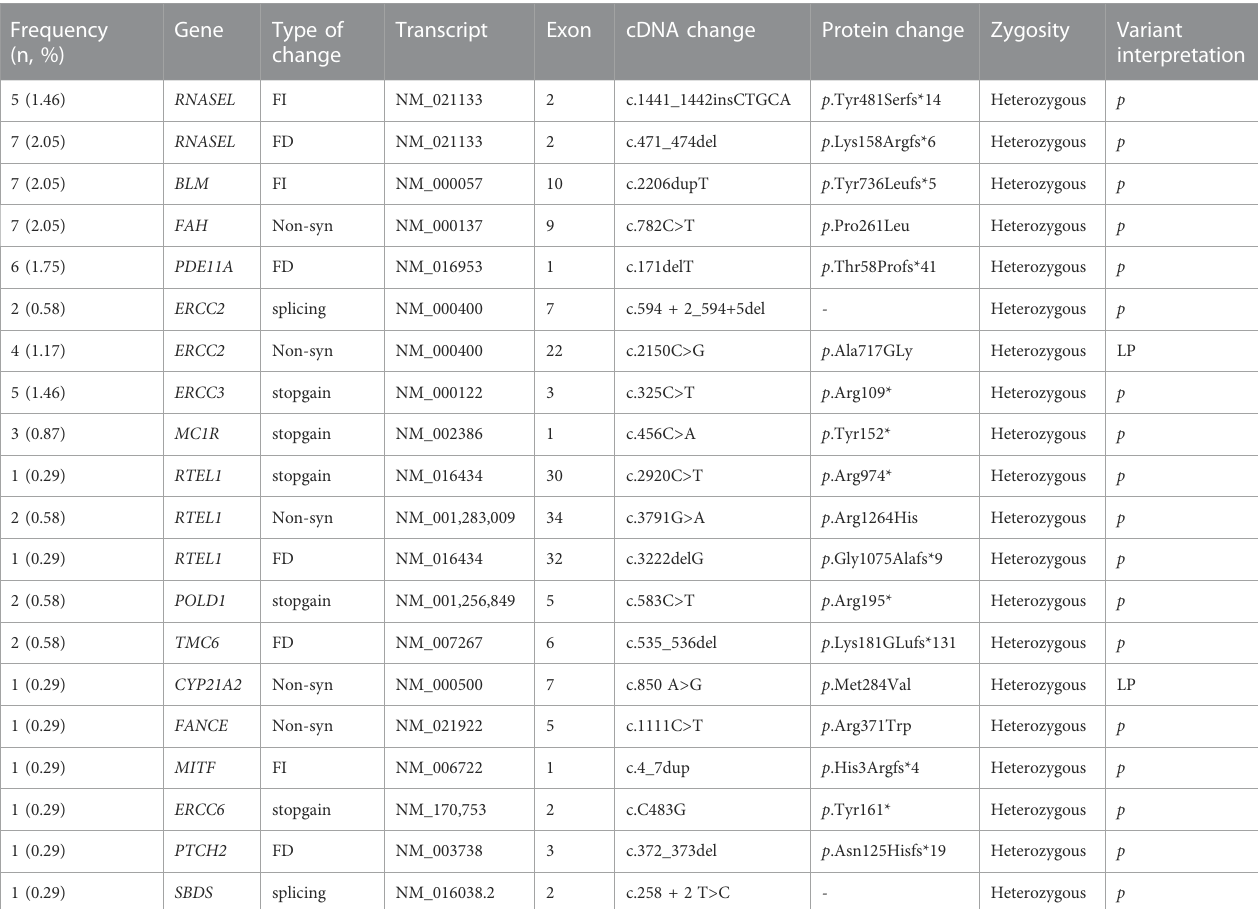
TABLE 3 Pathogenic and likely pathogenic alterations with unknown risk in 341 participants. Frequency (n,